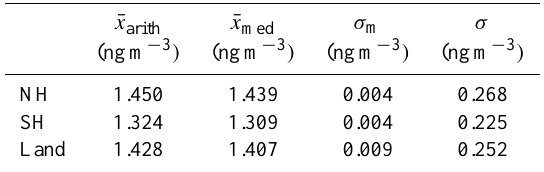
Table 1. Characteristics of the data assigned to one of the zones “NH”, “SH”, or “Land”. ¯ x arith : mean, ¯ x med : median, σ m : standard deviation of the mean, σ : standard deviation.